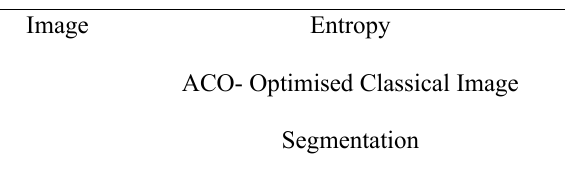
Table 2. Entropy for ACO Optimised Classical Image